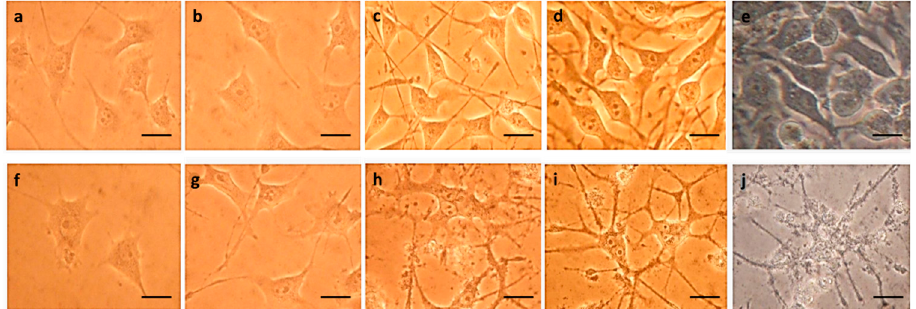
Figure 1. Morphological changes of MRC-5 cells induced by aza-reversine 2 (100 nM per well). ( a – e ) Control cells that were treated with DMSO (<1%) after: ( a ) 0, ( b ) 24, ( c ) 48, ( d ) 72, ( e ) 96 h; ( f – j ) cells that were treated with 2 (100 nM/well) after: ( f ) 0, ( g ) 24, ( h ) 48, ( i ) 72, ( j ) 96 h. All images were taken using optical microscopy with 40 × magnification. Scale bar: 0.5 μ m.